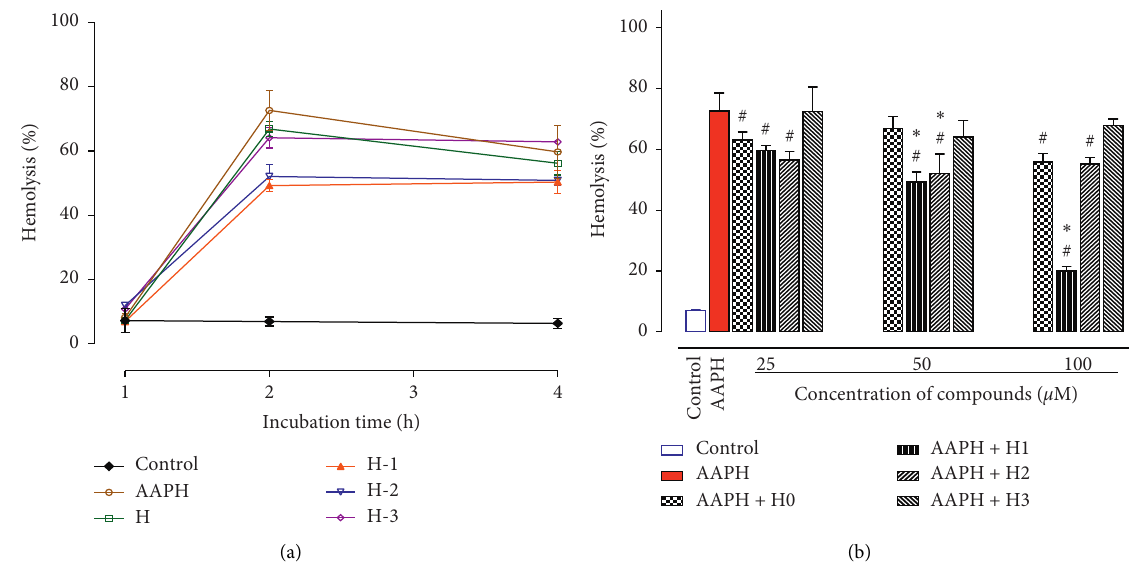
Figure 3: Protective effect duration of piperine derivatives on AAPH-induced erythrocyte hemolysis and time curves. (a) Time curves of the protective effects of piperine derivatives on AAPH-induced erythrocyte hemolysis at a concentration of 50 μ M. (b) The relationship between the protective effects of piperine derivatives at different concentrations and AAPH-induced erythrocyte hemolysis after 2h